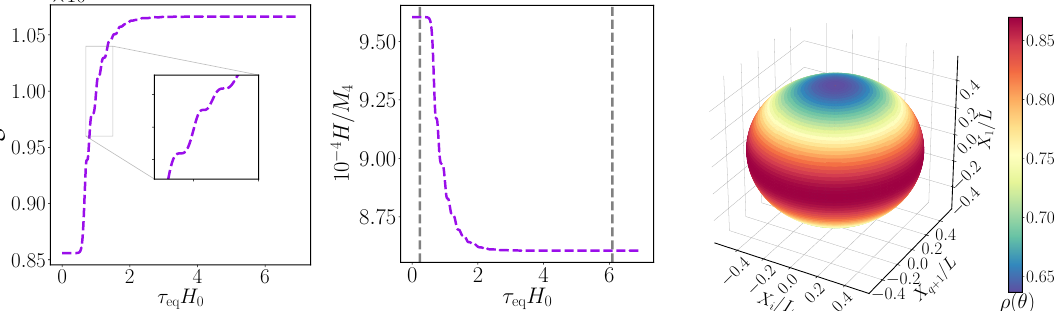
Figure 7 . A sample solution on the small volume branch with p = q = 4 , Λ D = 1 , H 0 /M 4 = 0 . 00096 , n = 436 . 13 and an initial ‘ = 2 perturbation. Left: the effective entropy which is increasing between the two stationary solutions. Middle: the effective four-dimensional Hubble rate eq. (2.20), with grey lines indicating the approximate initial and final times of the transition period, as defined in the text. Right: the three dimensional projection of the embedding of internal space at τ = 8 . 6 . The color shows the flux eq H 0